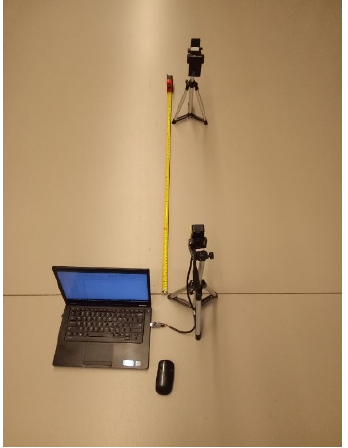
Figure 4. Testbed setup for 1-m distance range for UWB localization.